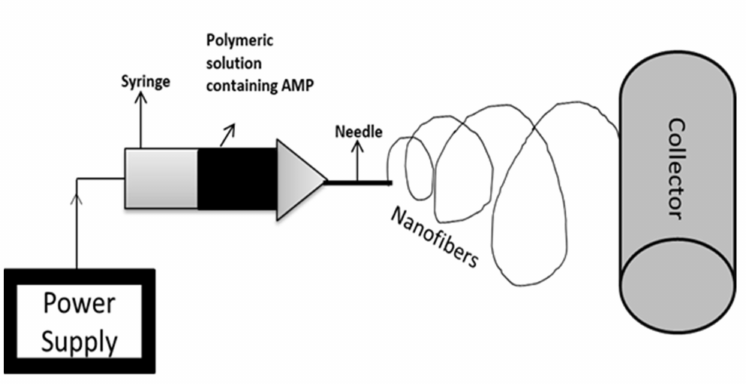
Figure 3. Schematic representation of electrospinning technique. Electrospinning is a nanofabrication method that involves the controlled flow of a polymeric solution placed in a syringe via a needle. The collector is the material on which nanofibers are